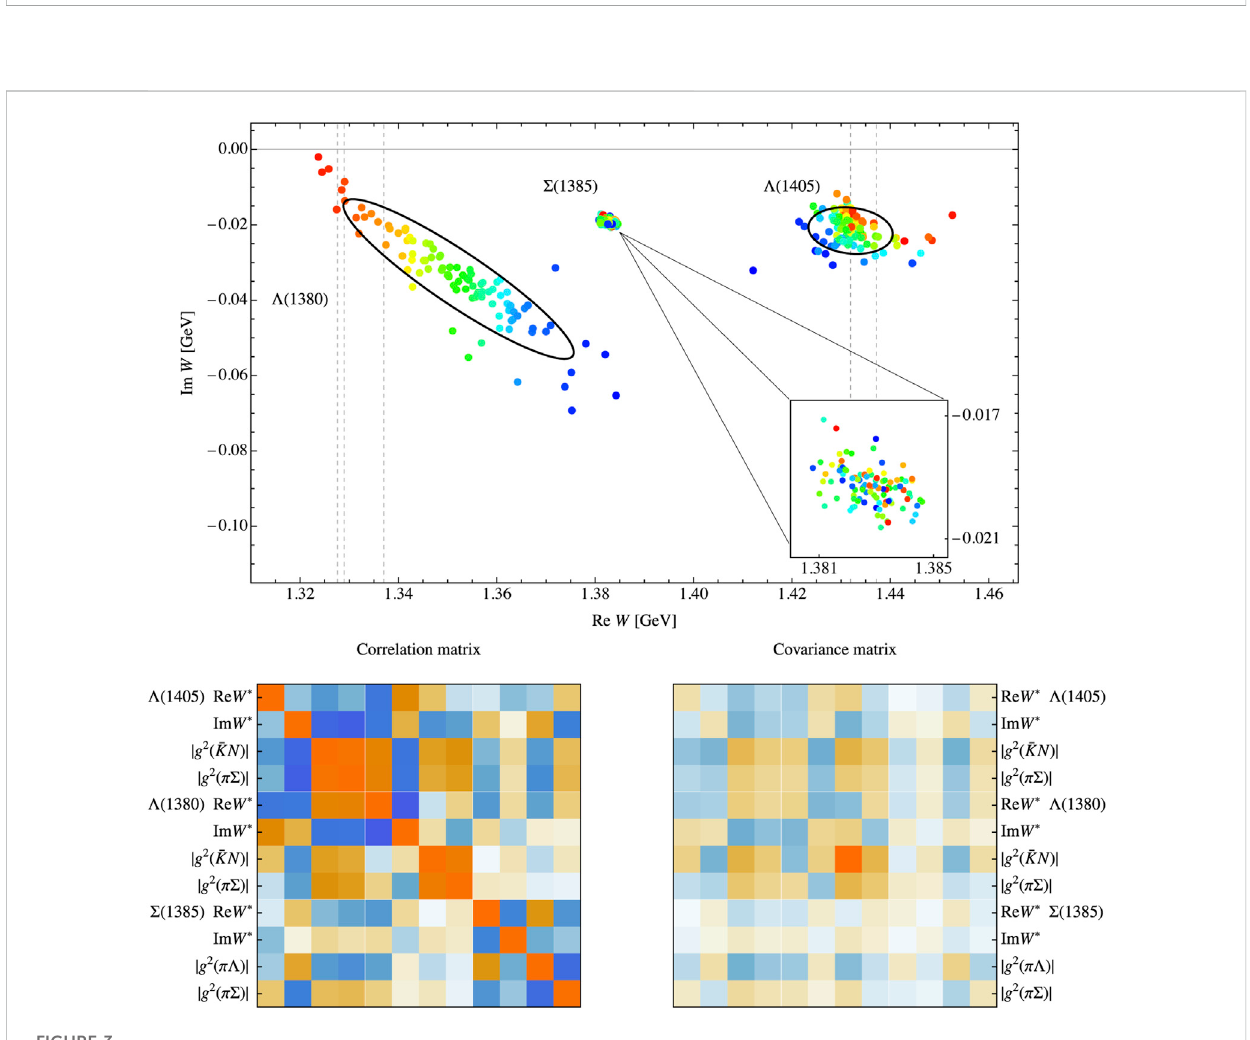
FIGURE 3 Summary of the all-data fi t ( F 1 ) results with respect to predicted resonance parameters. Top : Con fi dence regions of the pole positions. Each point corresponds to a pole from a re-sampling solution. Points of the same hue belong to the same sample. The ellipses show 1 σ uncertainty regions of each pole. Bottom :Covarianceandcorrelationmatrixbetweenpoleparameters.Theseparametersaretherealandimaginarypositionsofeachpoleaswellas the couplings to channels. Redder pixels correspond to more positive values and bluer pixels to more negative